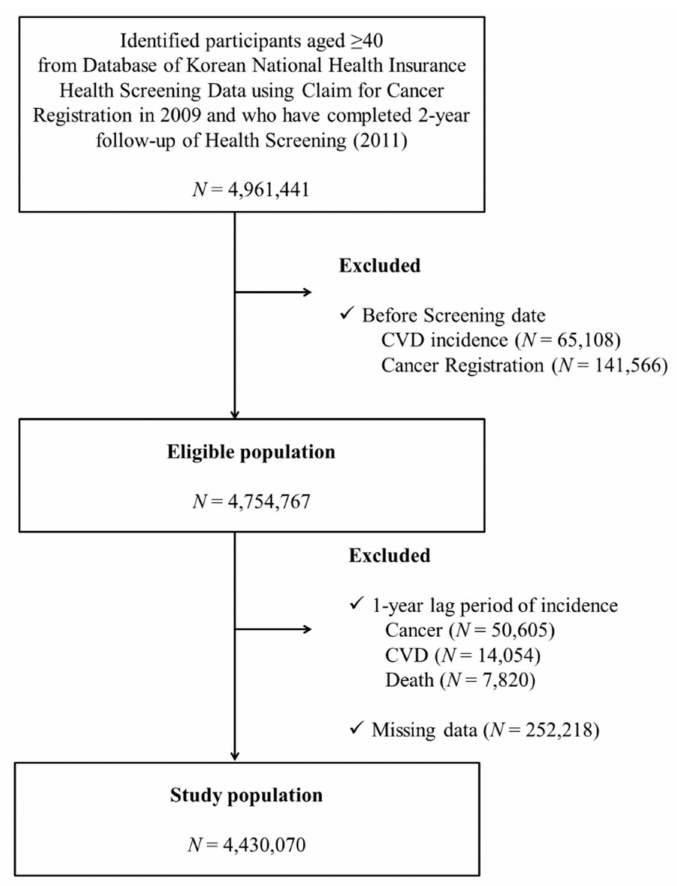
Figure 1. Flow chart of study participant